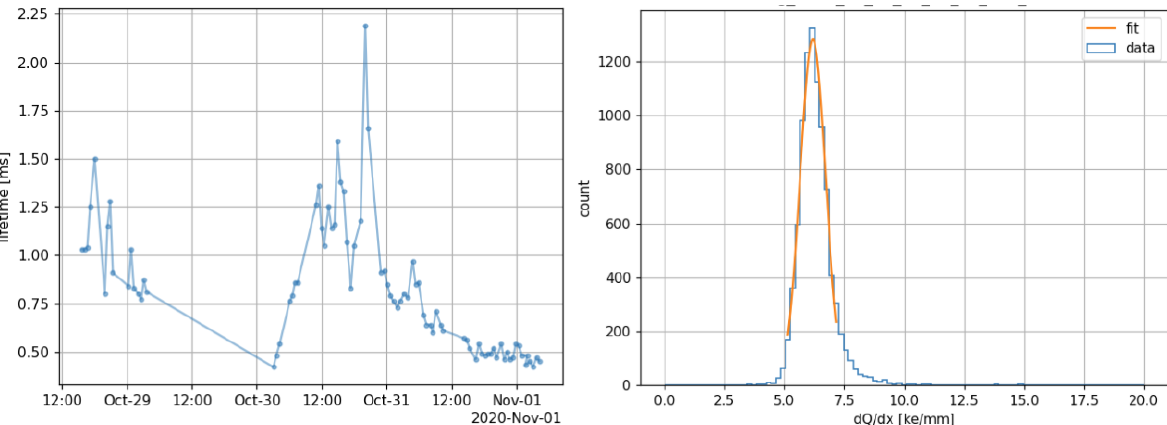
Figure 16. ( Left ) The electron lifetime measured using anode-cathode crossing cosmic ray muon tracks during the first operation of the SingleCube TPC. ( Right ) The distribution of muon energy loss in LAr is consistent with that expected for cosmic ray muon